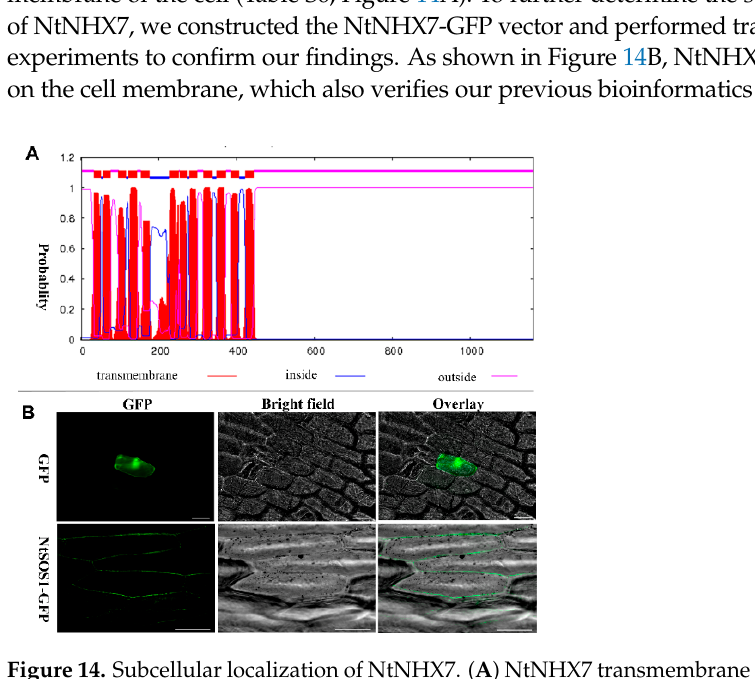
Figure 14. Subcellular localization of NtNHX7. ( A ) NtNHX7 transmembrane helix domain predic ‐ tion by TMHMM. ( B ) NtNHX7 subcellular localization by microprojectile bombardmen, 35S: GFP plants as control. Scale bar =100 μ m.